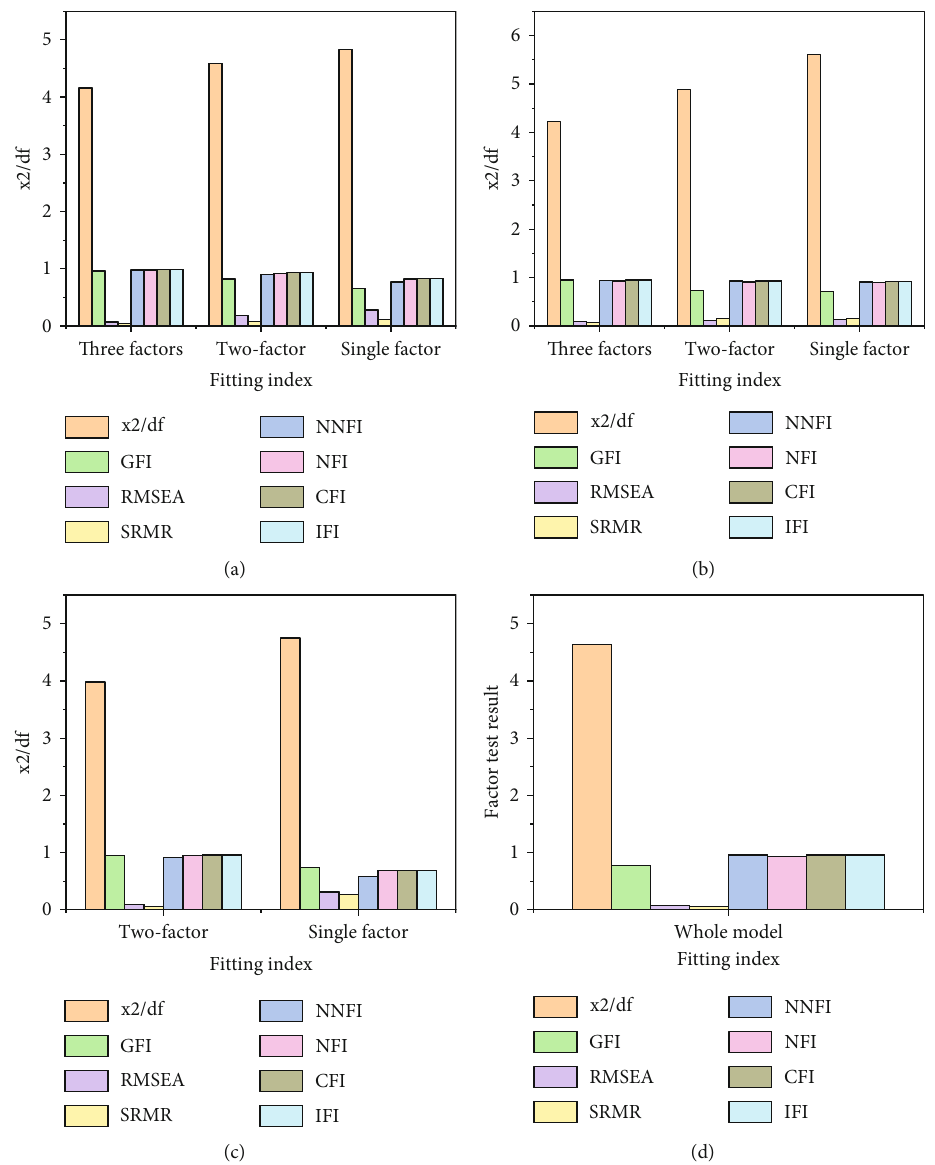
Figure 14: Model fi tting test results ((a) comparison of the main fi tting indexes of the type I music CFA (Color Filter Array); (b) comparison of the main fi tting indexes of type II music CFA; (c) comparison of the main fi tting indexes of the type III music CFA; (d) comparison of the main fi tting index of type IV music